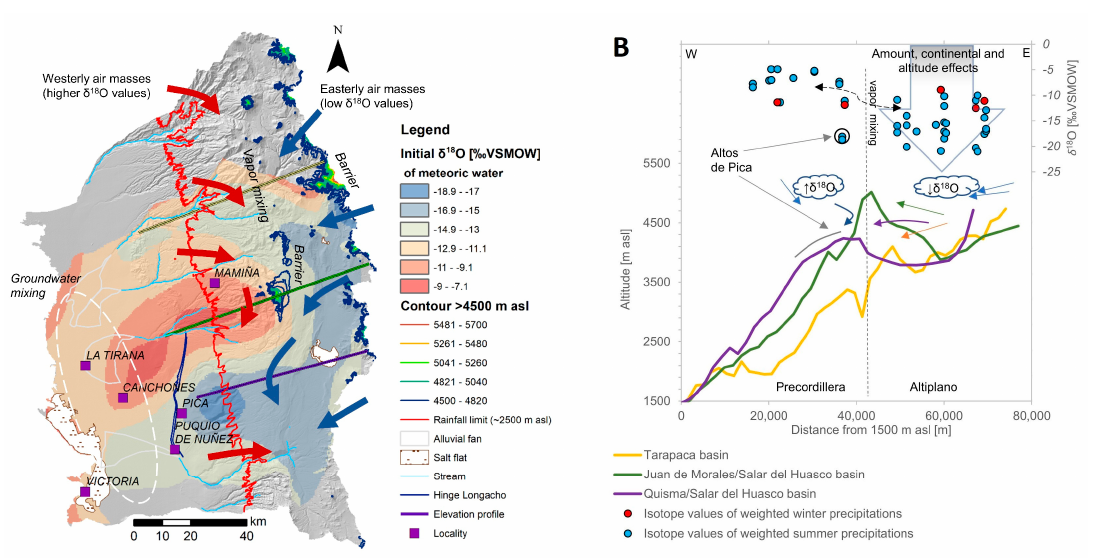
Figure 8. ( A ) Approximate initial δ 18 O values of meteoric waters in the study area prior to evaporation-driven fractionation. The map is based on the interpolation data of the kriging models for δ 18 O and δ 2 H (Figure 2A,B), arrows indicate suggested air mass contributions, ( B ) Schematic sketch of proposed topographic controls of isotope values in precipitations contributing to recharge in the PdT (isotope data of rain originates from Fritz et al. [3], Uribe et al. [8], and Aravena et al. [23]).